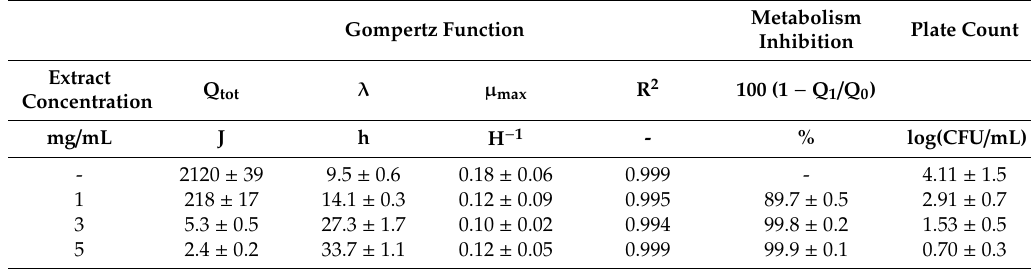
Table 2. Kinetic parameters obtained from the thermogram of E. coli growth and results obtained by the plate count technique.